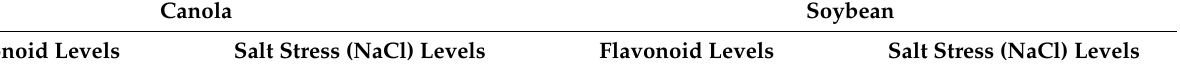
Table 1. Flavonoid and salt stress levels in canola and soybean experimentation. Canola